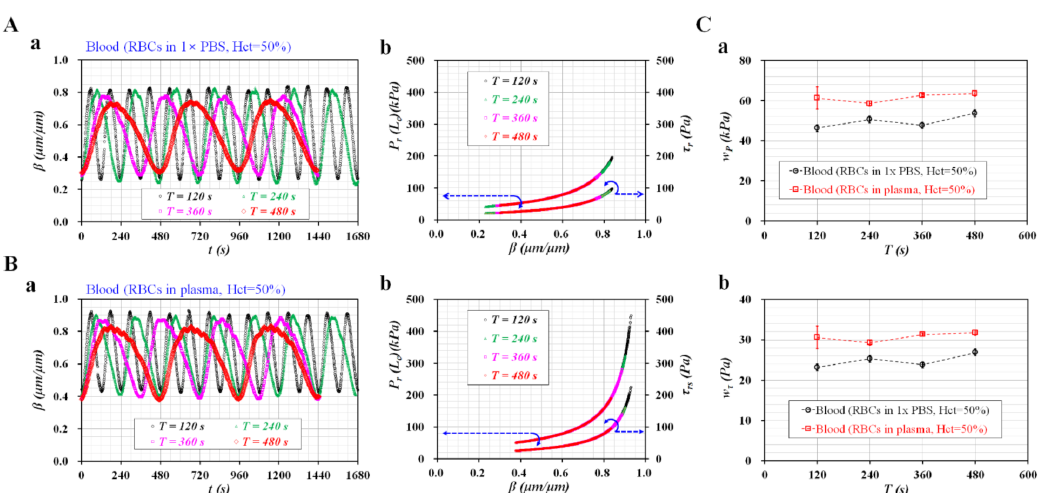
Figure 6. Quantitative evaluation of four parameters (i.e., P r , τ r , w P , and w τ ) under sinusoidal flow patterns. Glycerin solution (20%) as reference fluid was supplied at the flow rate of 0.5 mL/h. Blood (Hct = 50%) was prepared by adding normal RBCs into diluent (1 × PBS, plasma). Blood was delivered at the flow rate of Q t = 0.9 + 0.7 sin (2 × π × t / T ) mL/h. Here, period ( T ) was set to T = 120, 240, 360, and 480 s. ( A ) Contribution of T to P r (L c ) and τ r for normal RBCs suspended into 1 × PBS. (a) Temporal variations of β with respect to T . (b) Variations of P r ( L c ) and τ r with respect to β and T . ( B ) Contribution of T to P r (L c ) and τ r for normal RBCs suspended into plasma. (a) Temporal variations of β with respect to T . (b) Variations of P rs ( L = 7 mm) and τ r with respect to β and T . ( C ) Contribution of diluent (1 × PBS, plasma) and T to work ( w P , w τ ). (a) Variations of w P with respect to T and diluent (1 × PBS, plasma). (b) Variations of w τ with respect to T and